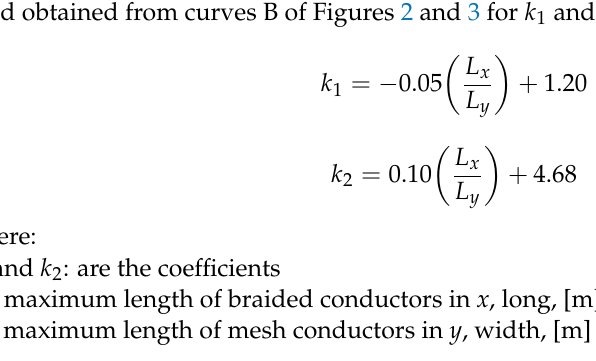
CURVE A - FOR DEPTH h = 0 y A = −0.04x+1.41 CURVE B - FOR DEPTH h = 1/10 √ AREA y B = −0.05x+1.20 CURVE C - FOR DEPTH h = 1/6 √ AREA y C = −0.05x+1.13 Figure 2. Coefficient k 1